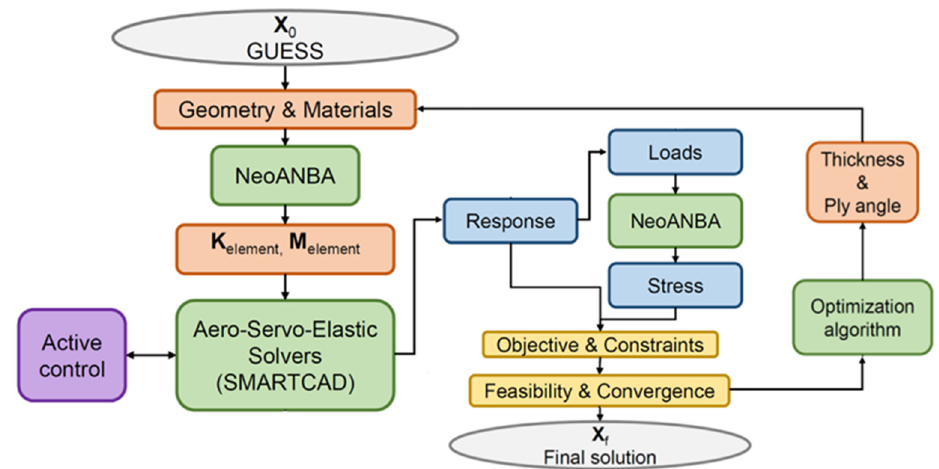
Figure 6. NeOPT’s work fl ow.